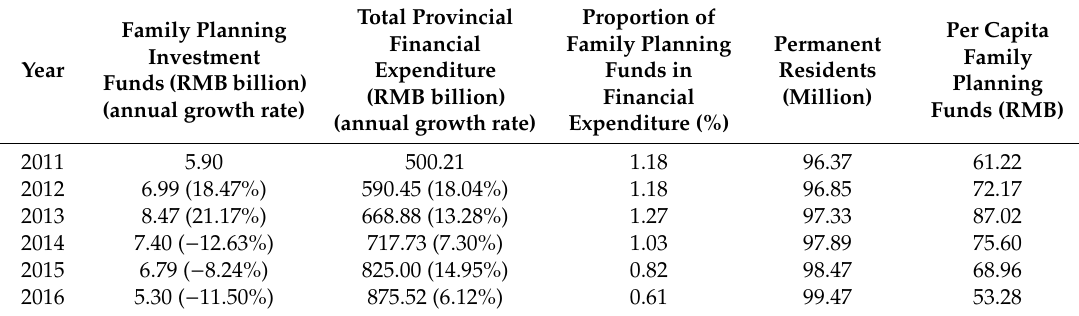
Table 1. 2006–2015 Family Planning Investment Funds, Financial Expenditure and its Proportion in Provincial Financial Expenditure.